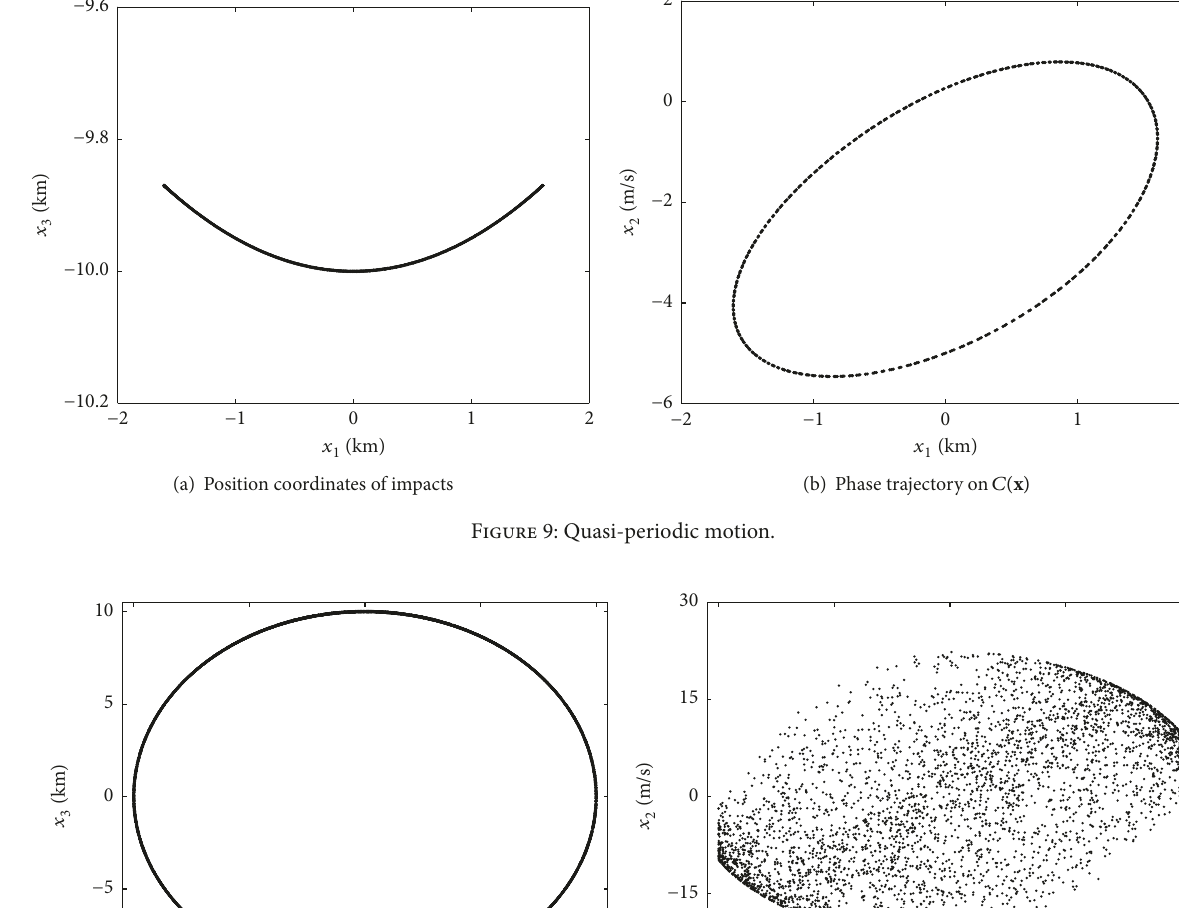
Figure 10: Irregular